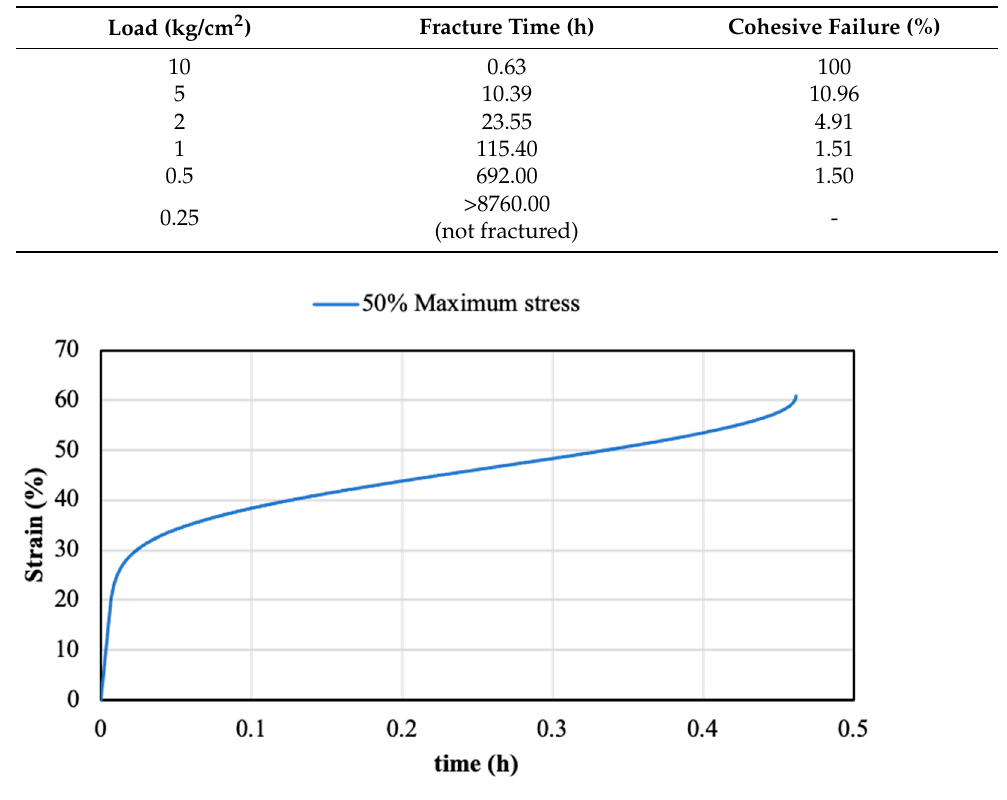
Figure 16. Characteristic creep curve of the FF under the 50% of the maximum shear tensile value.